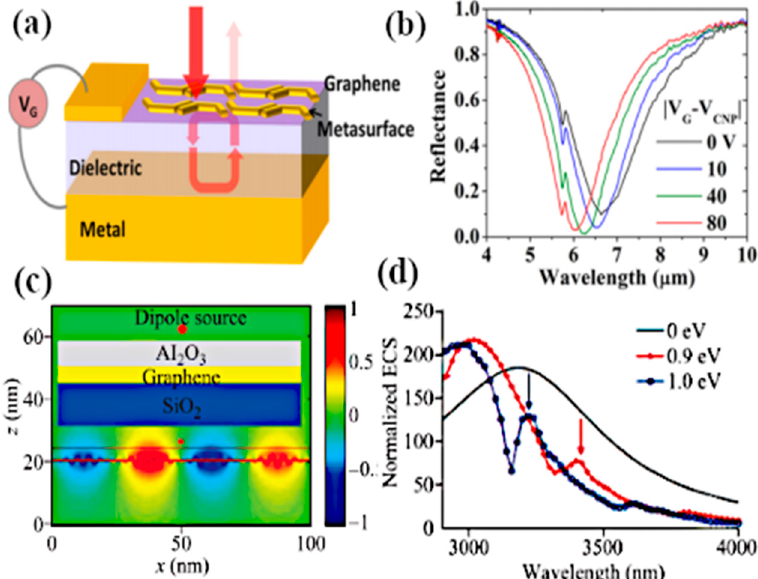
Figure 15. ( a ) Illustration of graphene-antenna-integrated metasurfaces. Antenna arrays are placed on the top of the graphene sheets, and dielectric acts as an optical cavity for incident radiation; ( b ) Tuning of resonance wavelength with increasing external gate voltage; ( c ) Distribution of near field as a thin metal oxide layer of Al 2 O 3 is inserted between graphene and a dipole source; ( d ) Normalized extinction cross section of the on/off mode coupling at different chemical potentials. © 2014 ACS, © 2016 Springer Nature. Taken and reprinted with permission from [174] and [184].